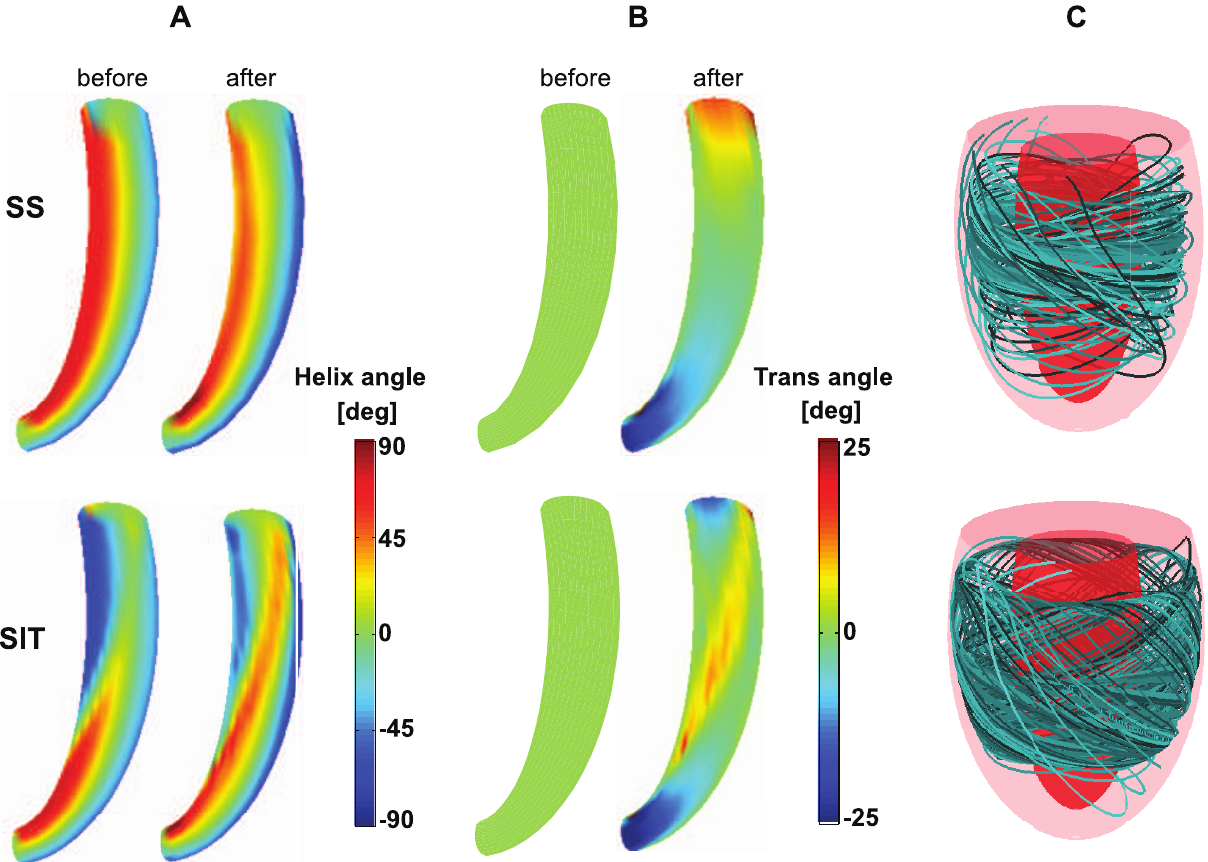
Figure 8. Structural results of simulation SS (top row) and SIT simulation MID (bottom row). A : Helix angle a h ,0 distribution on a long axis cross-section of the LV mesh before (left) and after (right) reorientation. B : Transverse angle a t ,0 distribution before (left) and after (right) reorientation. C : 3-D visualization of fiber paths through the LV mesh after reorientation. Ten paths are shown which started at different locations between endo- and epicardium. The color of the path refers to the starting point.